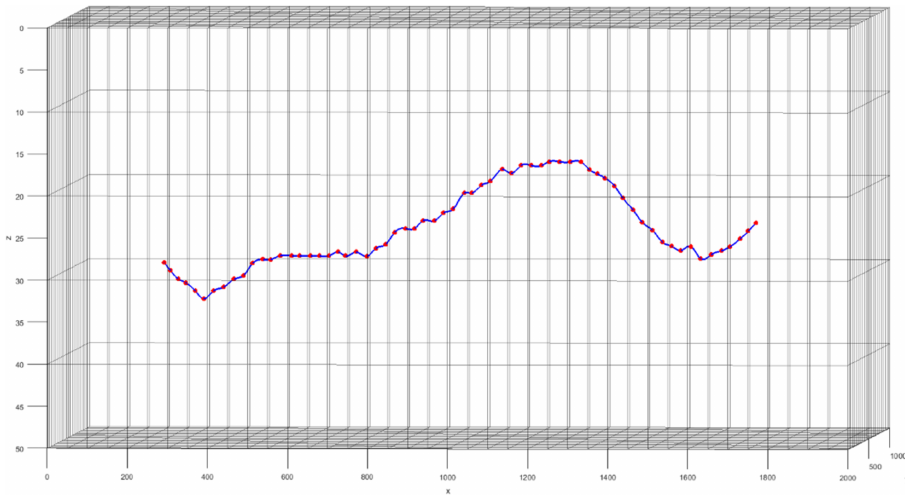
Figure 1. The case well trajectory with a hilly-terrain